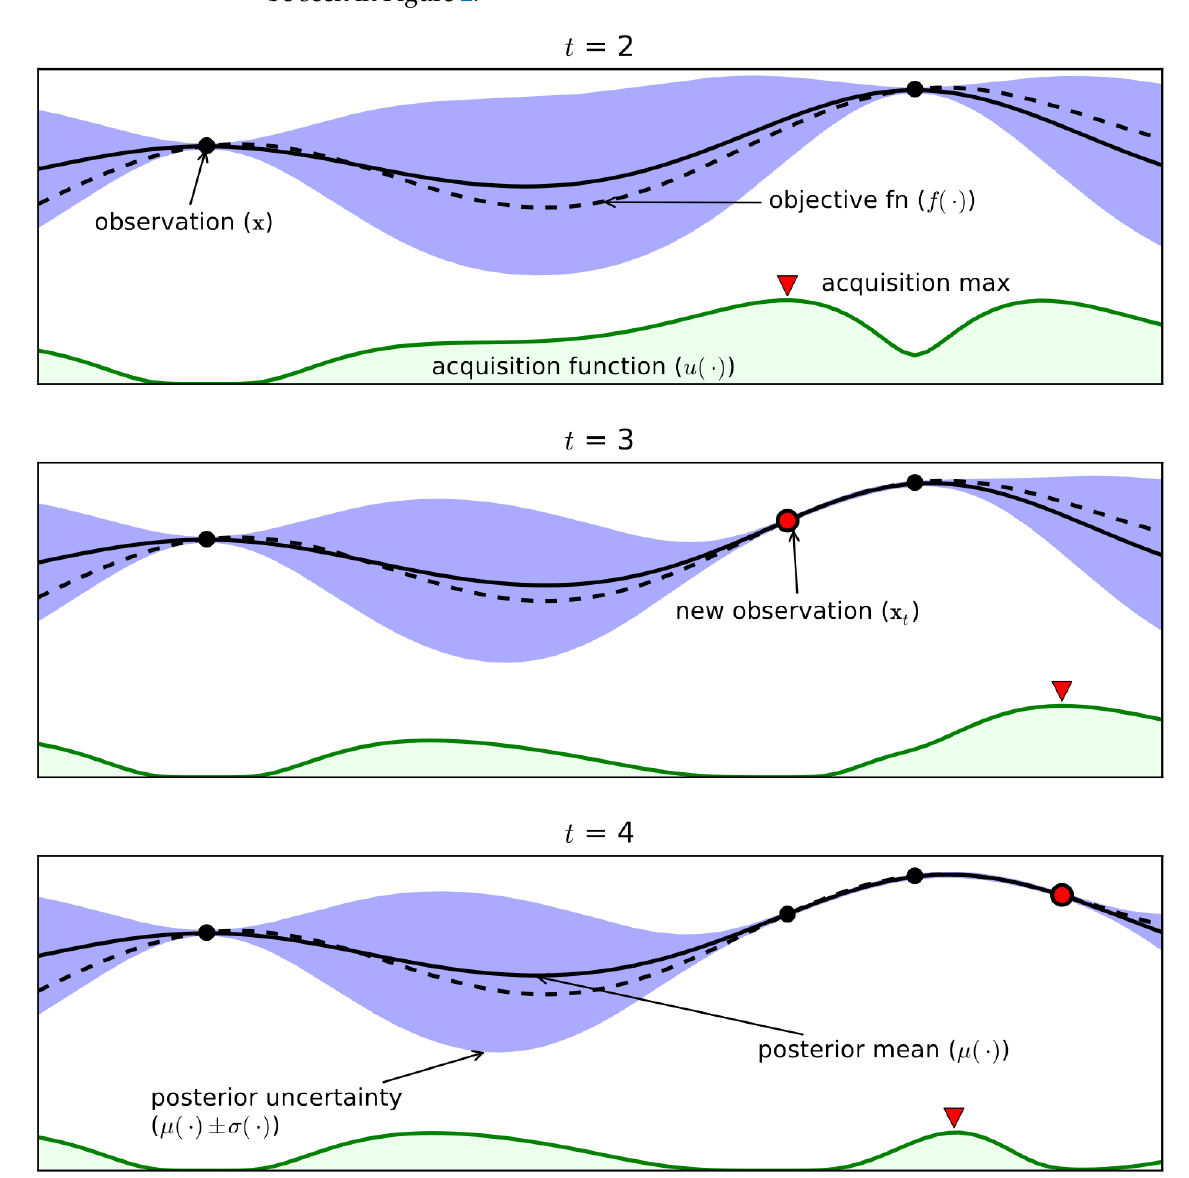
Figure 2. BO in 3 steps. The dotted function is the objective function to be optimized, the black function is the posterior mean, and the purple area is the confidence level of the acquisition function, i.e., UCB, EI, and so forth